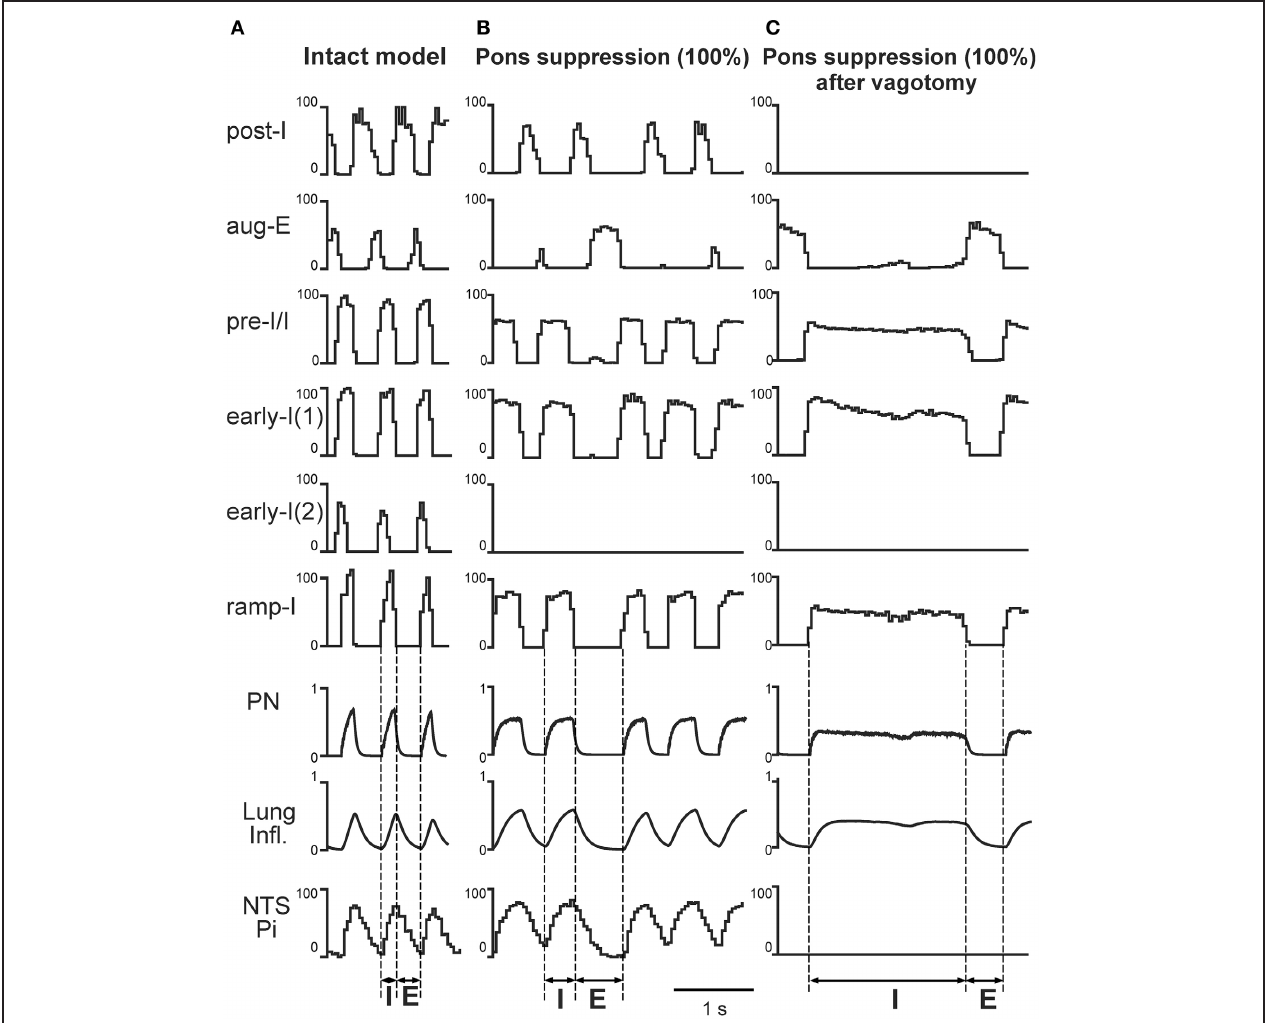
FIGURE 5 | The effects of pontine suppression before and after simulated vagotomy. Activity of major medullary [post-I, aug-E, early-I(1), pre-I/I, early-I(1), early-I(2), and ramp-I], NTS (Pi) and pontine (I, IEe, and E) neural populations, lung inflation and PN activity under control conditions